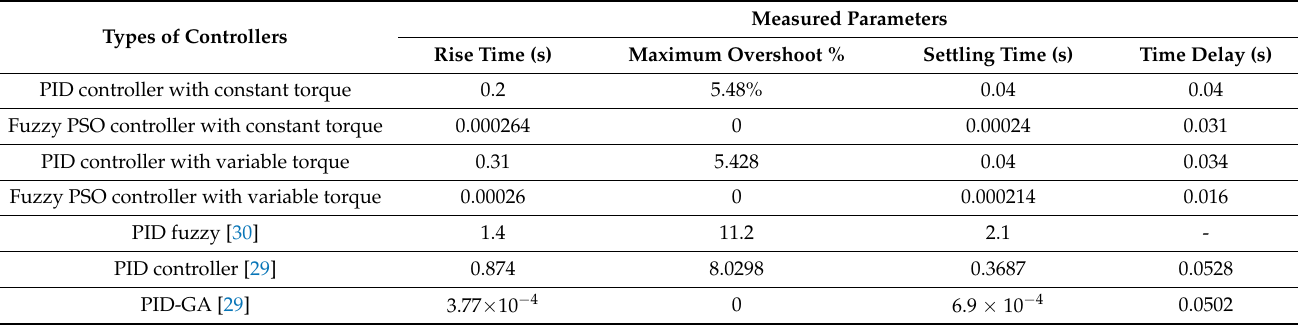
Table 5. Comparative analysis of different controllers.